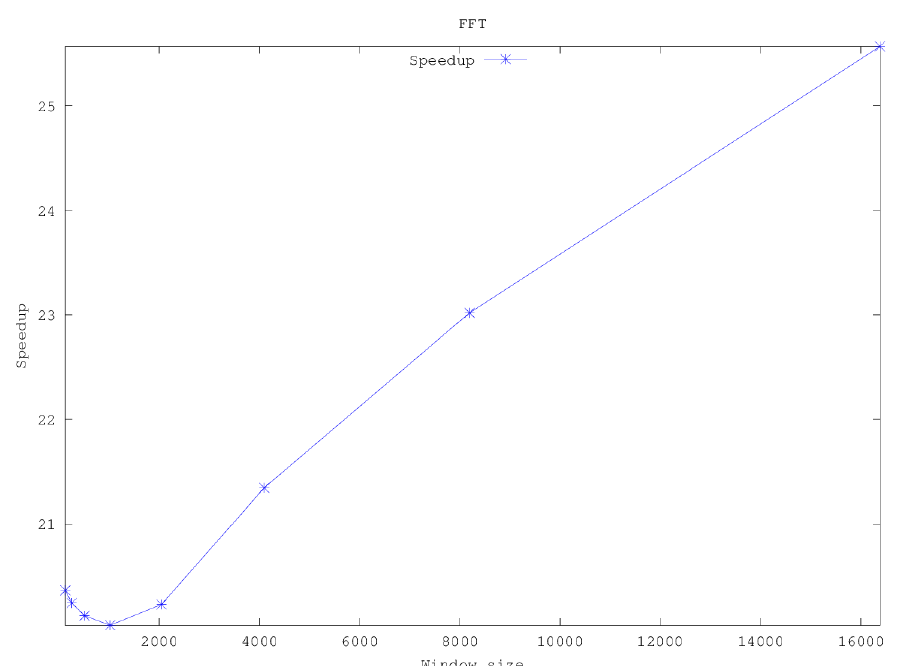
Figure 12. Fast Fourier Transform (FFT): speedup vs. window